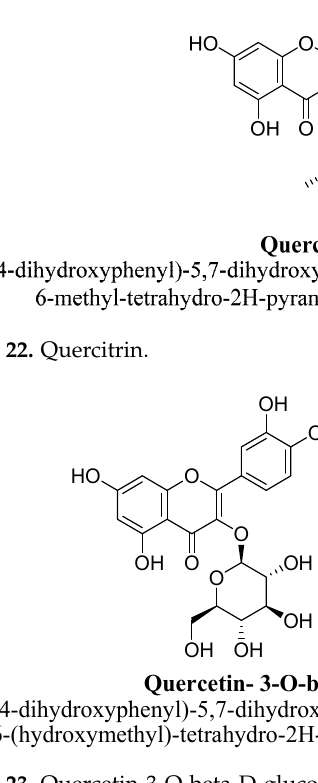
Figure 23. Quercetin-3-O-beta-D-glucoside.